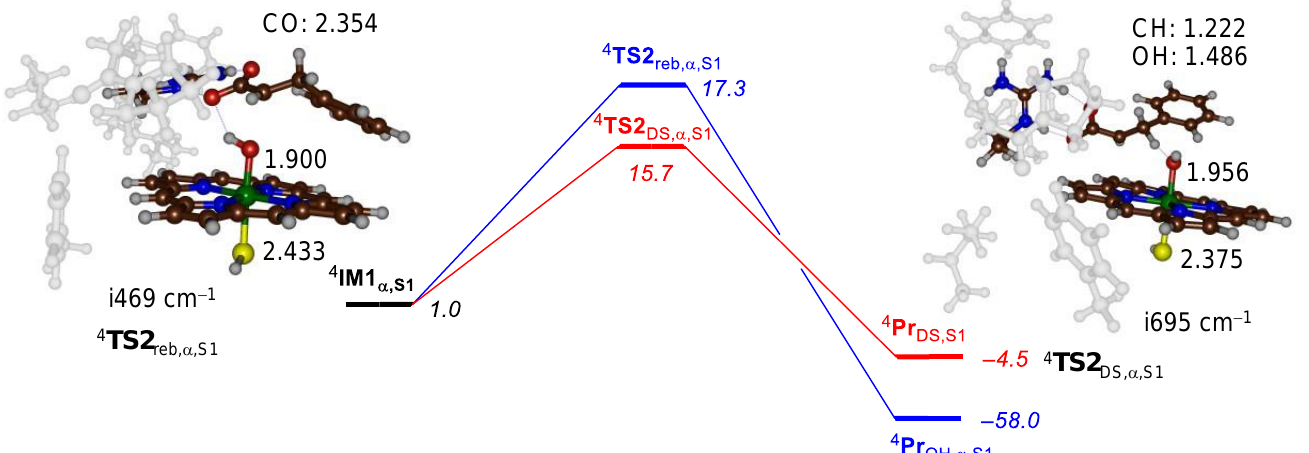
Figure 4. Substrate desaturation and hydroxylation bifurcation pathways for substrate S1 from the radical intermediate IM1 α ,S1 of P450 OleT JE . The middle panel gives energies relative to 4 R e S1 in kcal mol − 1 as obtained at the ∆ E+ZPE level of theory. Transition state structures are shown on the side with bond lengths in angstroms and the imaginary frequency in the transition state in cm − 1 .